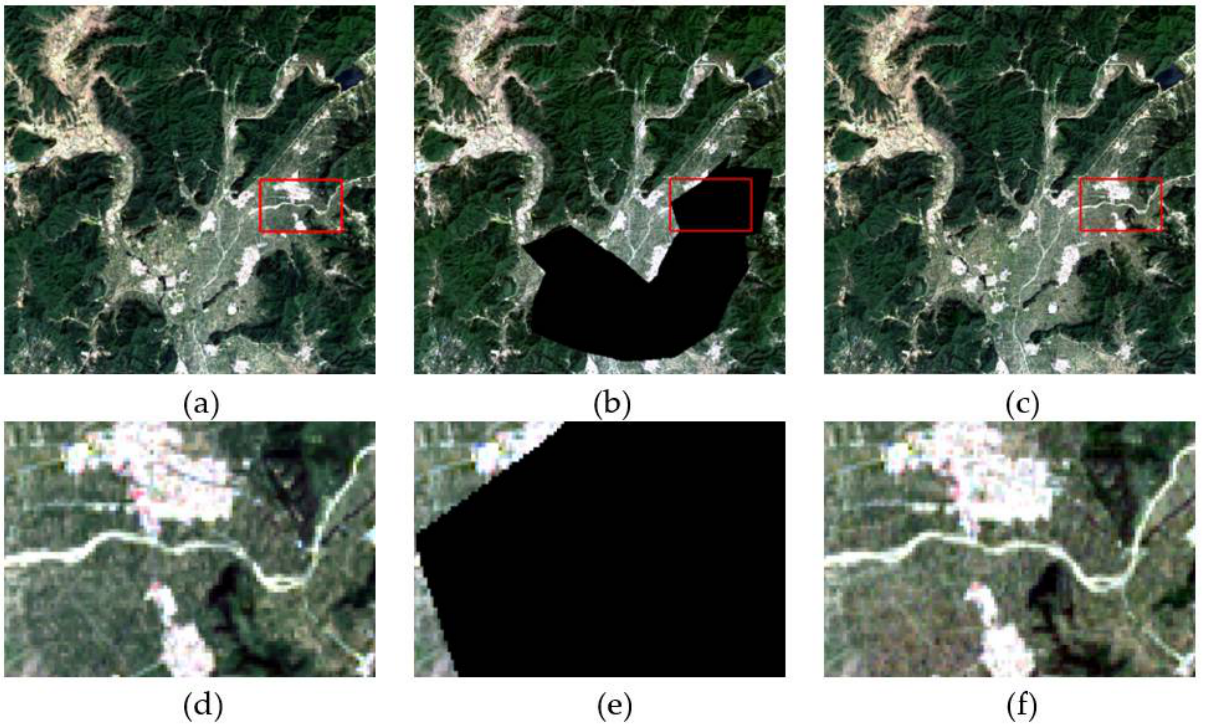
Figure 14. The simulated experiment with missing area of 19.26%: ( a ) original image; ( b ) simulated cloudy image; ( c ) reconstructed image; ( d – f ) enhanced details from red boxes in ( a – c ).